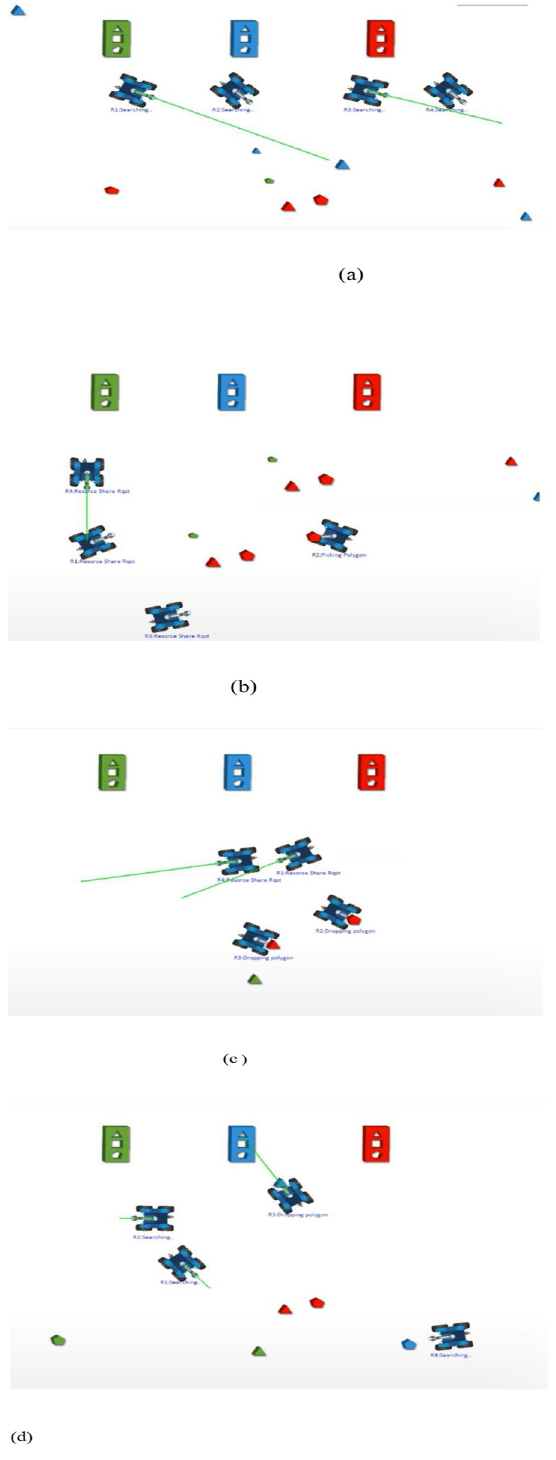
Fig 7. Simulation Scenario (a) Initial Position (b) R 4 encounters a robotic arm failure and R 3 encounters an RGB failure (c) R 3 is selected by R 4 for its lowest bid for robotic arm sharing (d) R 3 completes the task which was detected by R 4 .